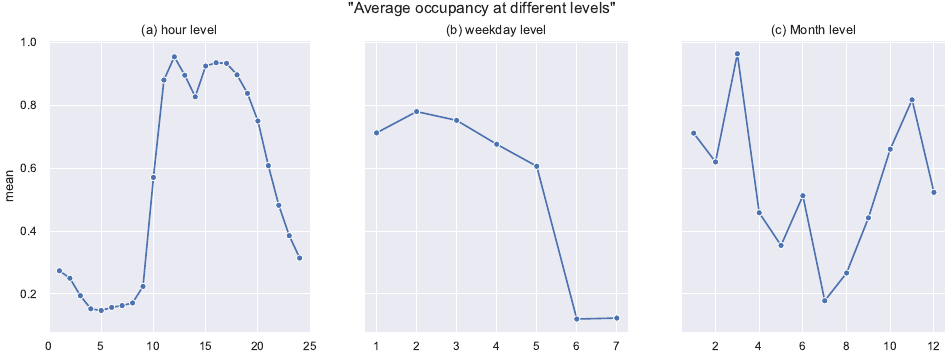
Figure 4. Average occupancy at different time levels: ( a ) hourly level, ( b ) daily level, and ( c ) monthly level.